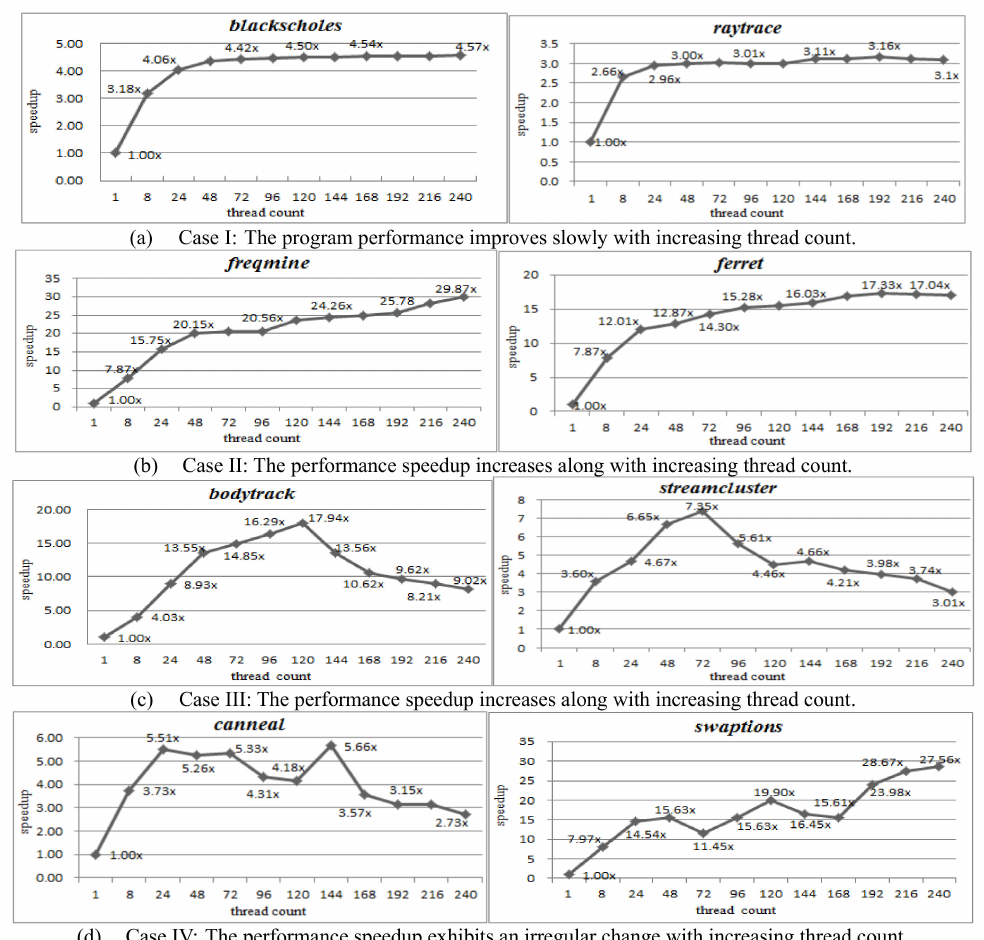
Figure 1. The impact of thread count on performance. ( a ) Case I: The program performance improves slowly with increasing thread count. ( b ) Case II: The performance speedup increases along with increasing thread count. ( c ) Case III: The performance speedup increases along with increasing thread count. ( d ) Case IV: The performance speedup exhibits an irregular change with increasing thread